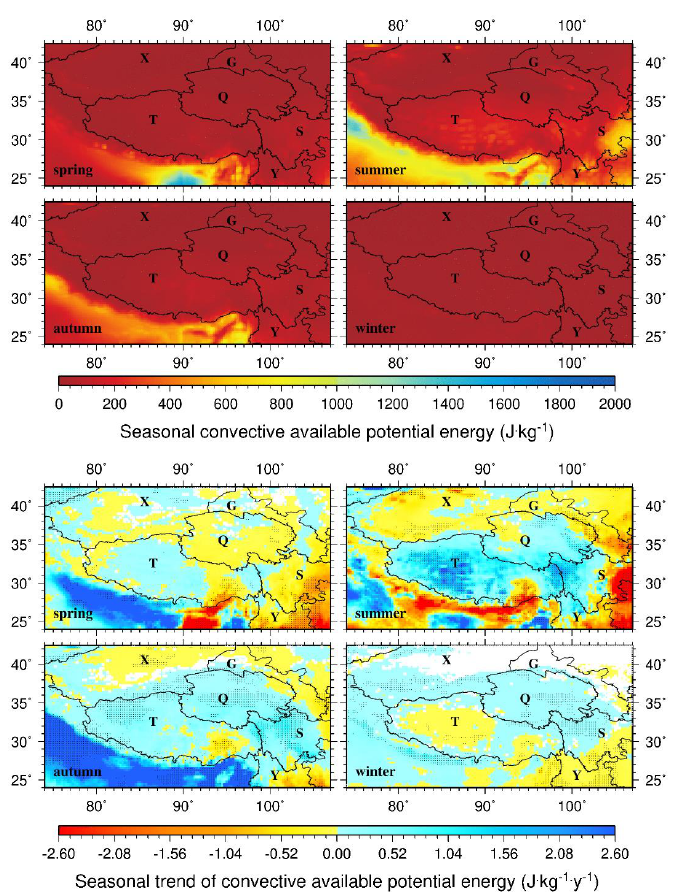
Figure 14. Spatial distributions of the means and trends of ERA5 CAPE during 1979–2015.